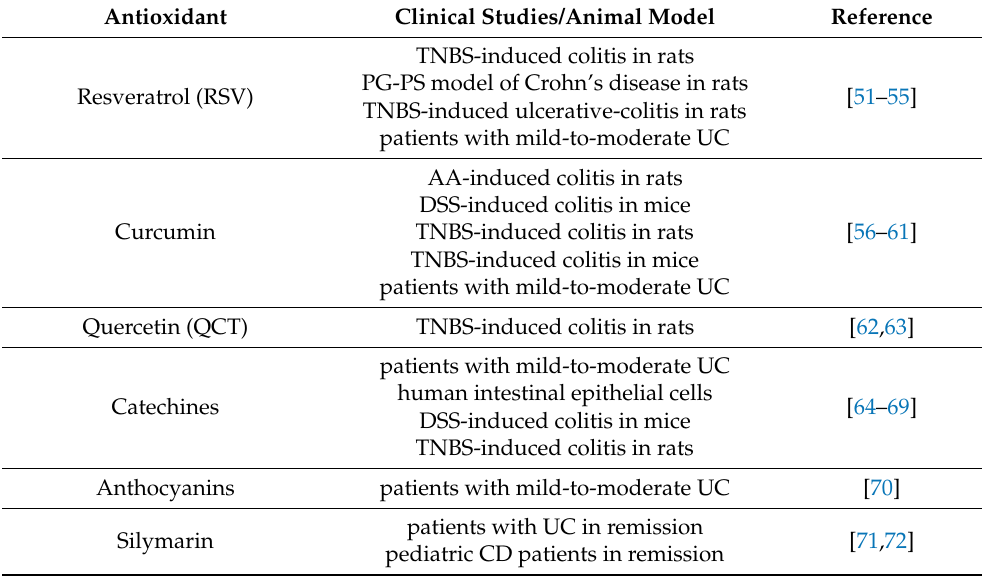
Table 2. Natural antioxidants used in IBD